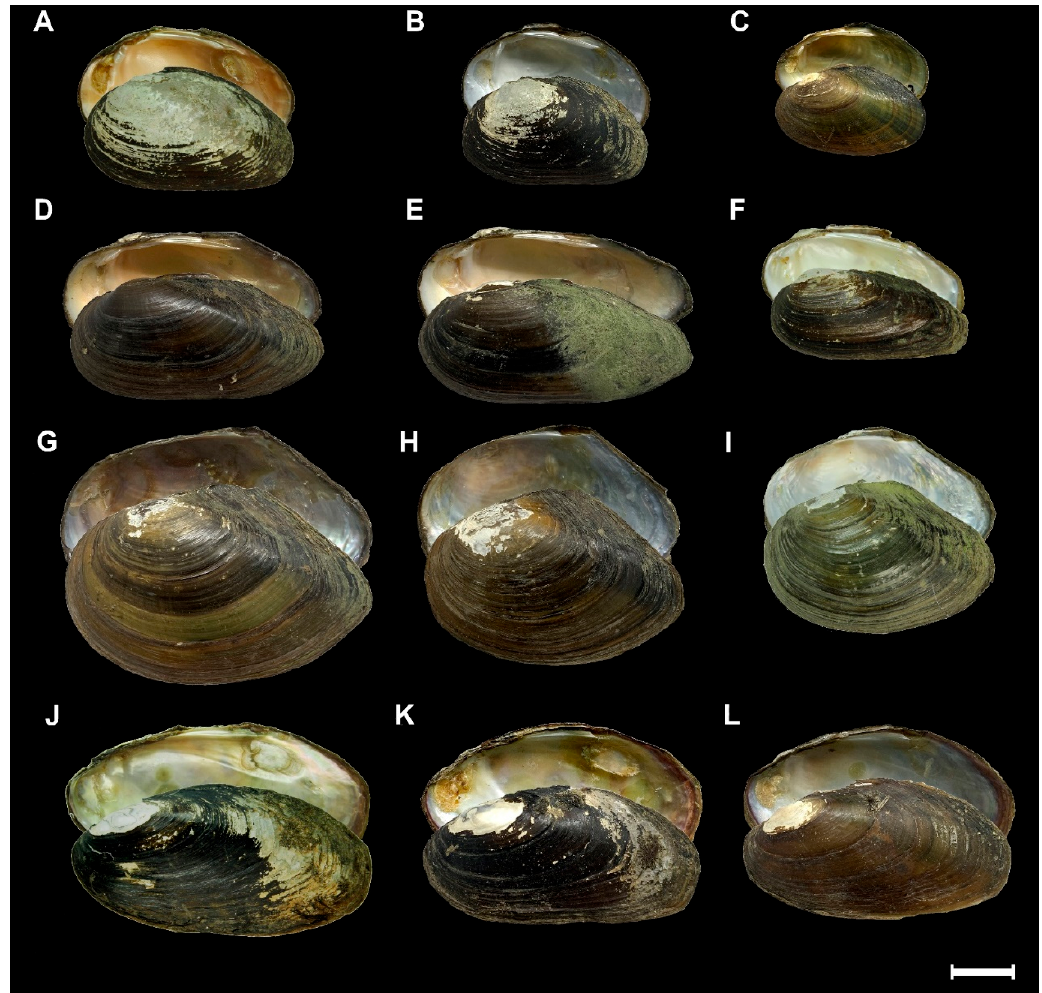
Figure 8. Shells of freshwater mussels (Unionidae) from Montenegro (RMBH collection): Unio carneus : RMBH biv1201/2 ( A ), RMBH biv1204/1 ( B ), and RMBH biv1204/2 ( C ); U. elongatulus : RMBH biv1206/8 ( D ), RMBH biv1209/2 ( E ), and RMBH biv1210/5 ( F ); Anodonta exulcerata : RMBH biv1208/1 ( G ), RMBH biv1207/2 ( H ), and RMBH biv1205/5 ( I ); Microcondylaea bonellii : RMBH biv1203/6 ( J ), RMBH biv1203/4 ( K ), and RMBH biv1203/5 ( L ). Table 2. Species richness and number of collected specimens of freshwater mussels in